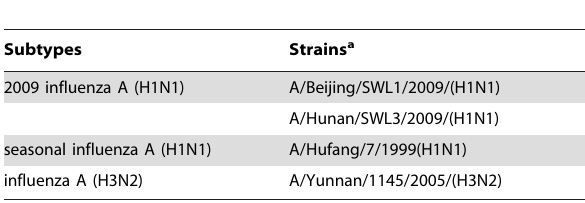
Table 3. Positive strains of influenza A virus.